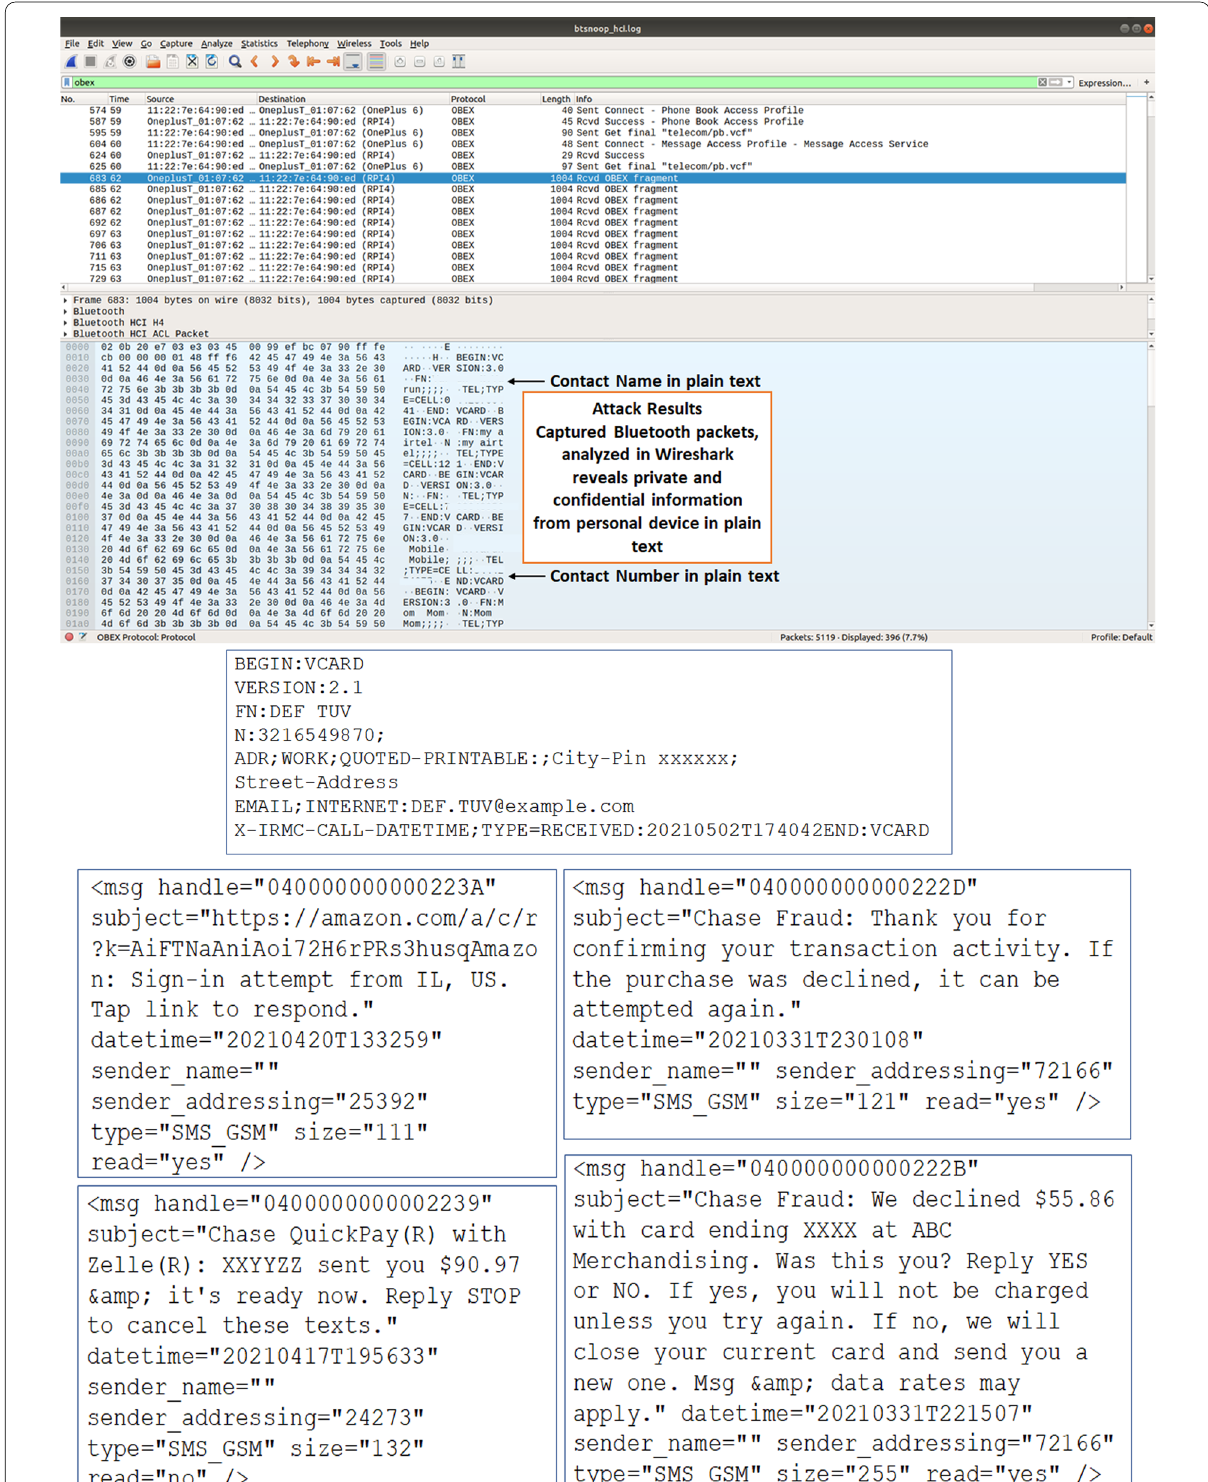
Fig. 8 Attack results in Wireshark revealing phone contacts and confidential user information to the attacker in plain